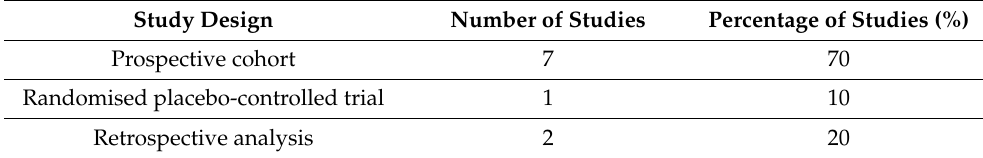
Table 1. Summary of study designs included in this systematic review.